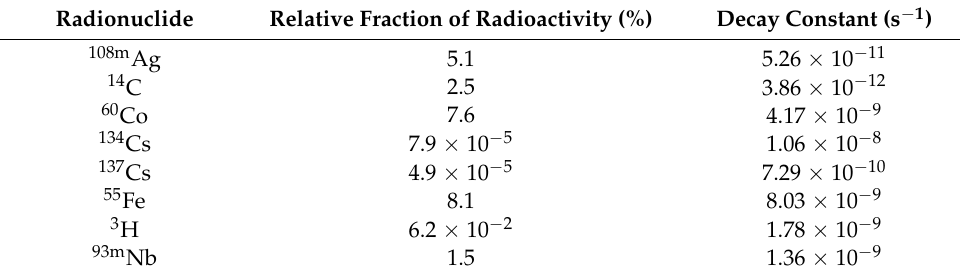
Table 1. Target radionuclides for the derivation of the preliminary